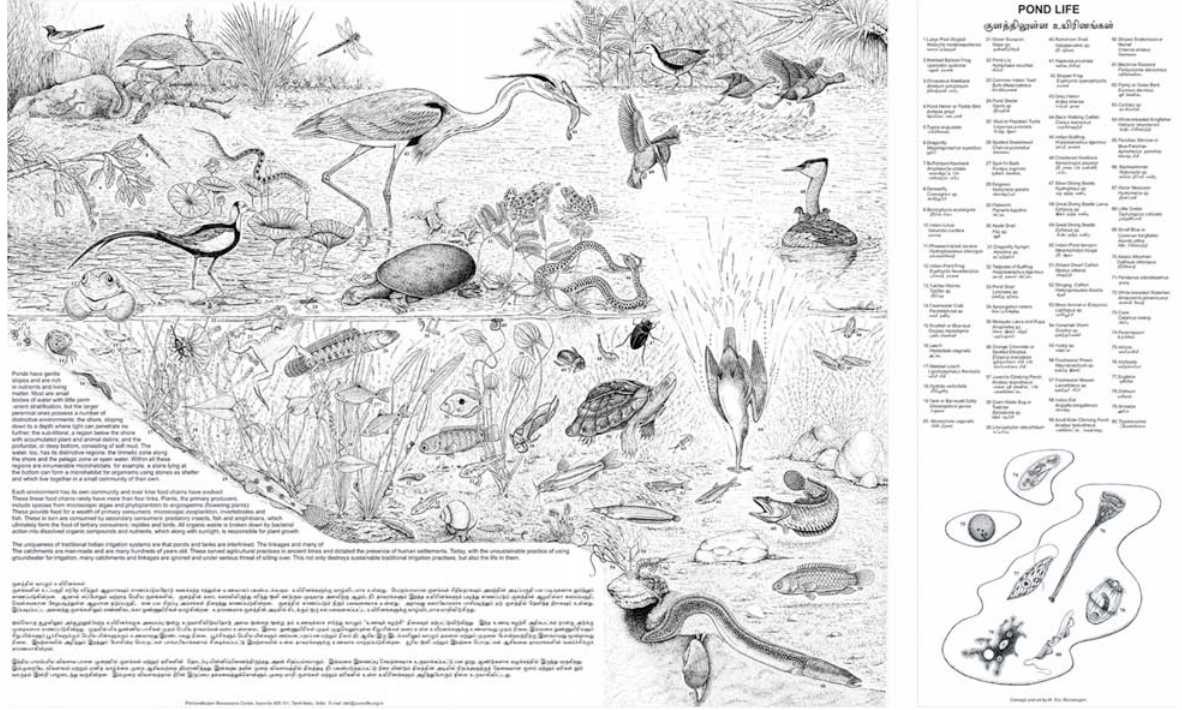
Image 17. Pen and ink representation of life in a typical pond along the southern Coromandel Coast of India. The drawing is interspersed with informative text and 80 species have been represented (from vertebrates to microscopic life). A feature of this poster is the ‘undercurrent’ graphic representation of the web of life (with predation playing a major role).